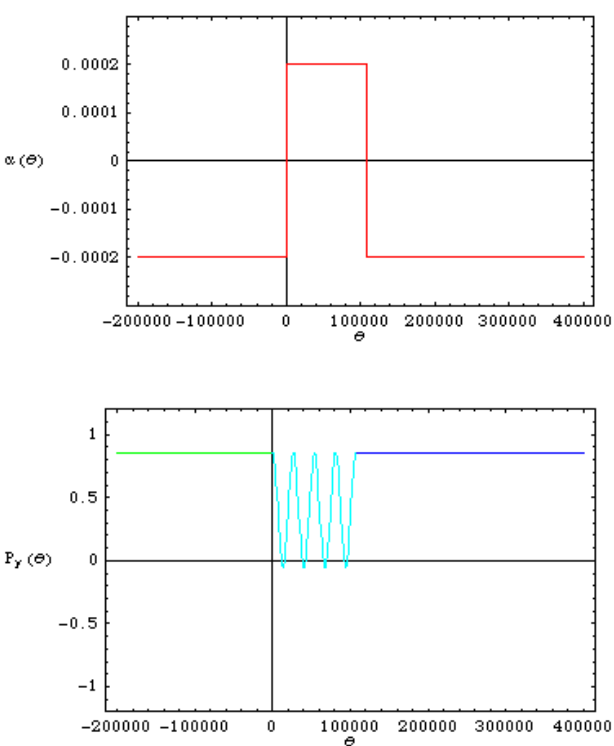
FIG. 2. (Color) The upper figure shows the resonance crossing pattern (cid:8) (cid:2) (cid:6) (cid:4) of a particle as a function of (cid:6) . The lower figure (cid:2) (cid:6) (cid:4) as the particle makes the resonance shows the polarization P y j (cid:1) crossings. Parameters used are A (cid:1) 2 (cid:11) 10 (cid:3) 4 , j (cid:5) 0 (cid:1) (cid:3) 2 (cid:11) 10 5 , (cid:6) (cid:1) 0 , (cid:3) (cid:1) 4 (cid:7) . The two jumps 1 : 2 (cid:11) 10 (cid:3) 4 , (cid:6) 0 1 1 destructively interfere as the polarization makes 4 complete oscillations during the time between the two jumps. The three colors in the lower figure give the polarization during the three time periods before first crossing, between the two crossings, and after the second crossing, respectively. The exact value of the does not launching time (cid:6) 0